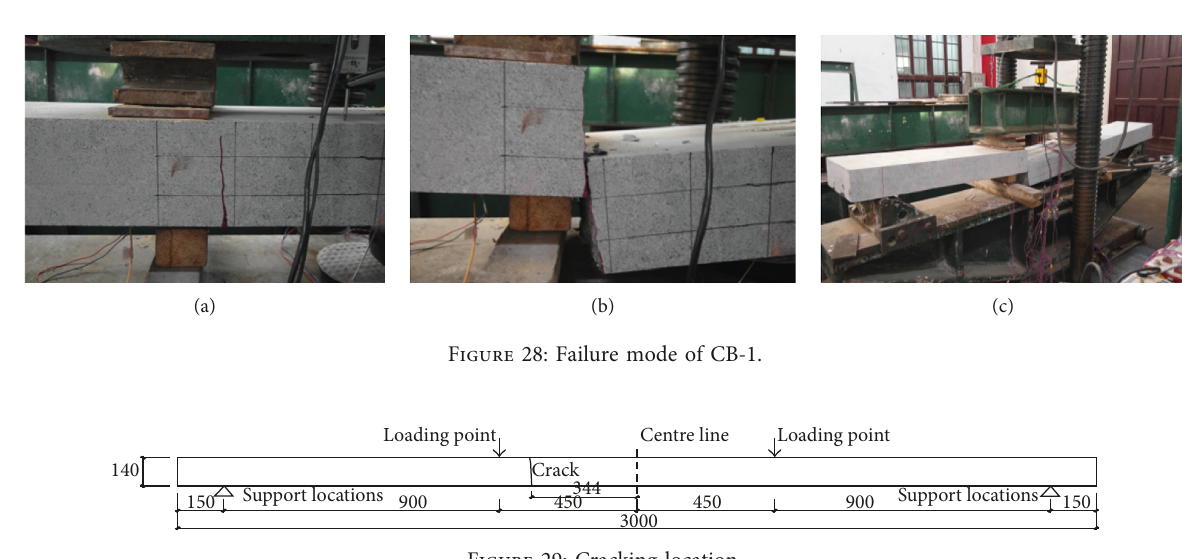
Figure 29: Cracking location.